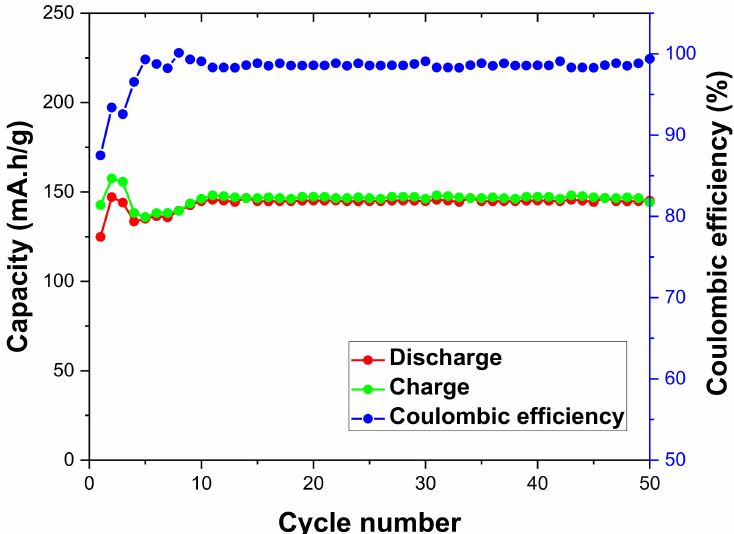
Figure 15. Charge / discharge cycling performances for the LiFePO 4 –PANI composites. The data were obtained by charging and discharging at 0.1